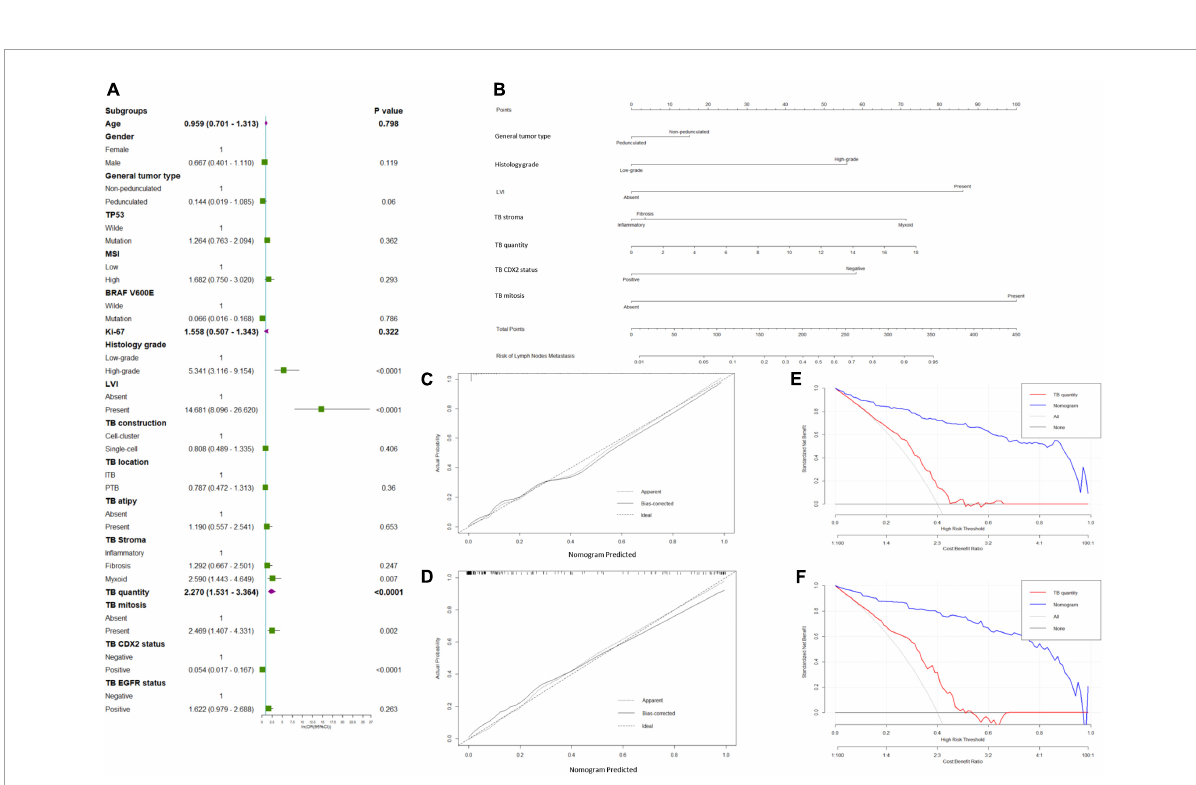
FIGURE2 Predicted model of lymph node metastasis (LNM). (A) Forest plots to decipher the risk factors associated with LNM identified in the univariate logistic regression analysis; (B) newly developed nomogram for predicting LNM in patients with pT1 CRC. The calibration curve for predicting LNM of pT1 CRCs in the (C) training and (D) validation cohorts. Decision curve analysis of the nomogram and TB quantity alone for predicting LNM in patients with pT1 CRC in the (E) training cohort and (F) validation